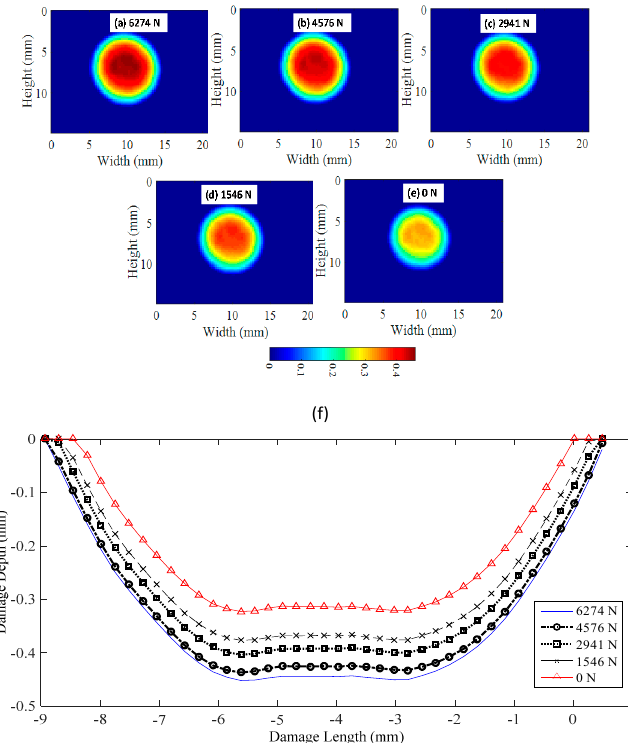
Figure 16. Damage geometry in the contact region during the unloading path for a 6 mm-thick specimen. ( a ) Maximum load reached to 100% of the cylinder displacement with a maximum of − 2 mm; ( b – d ) Stages representing the elastic recovery during the unloading path; ( e ) Permanent damage in the plate; ( f ) Profiles of the contact damage depth for the different stages during the unloading path.